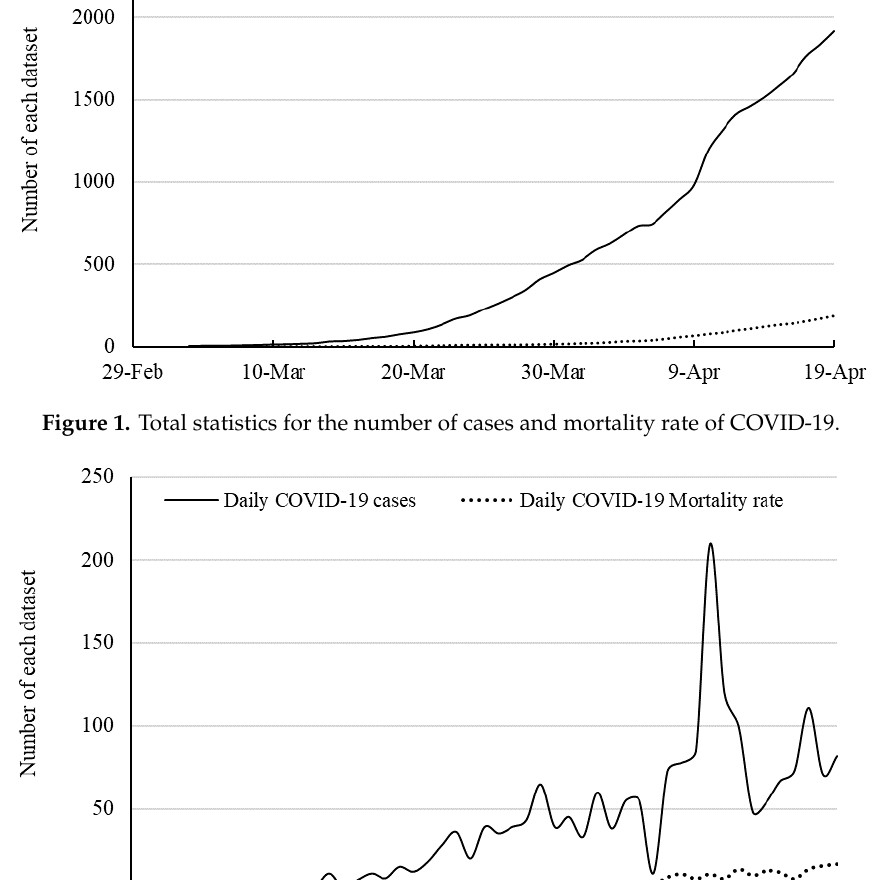
Figure 2. Daily statistics for the number of cases and mortality rate of COVID-19.